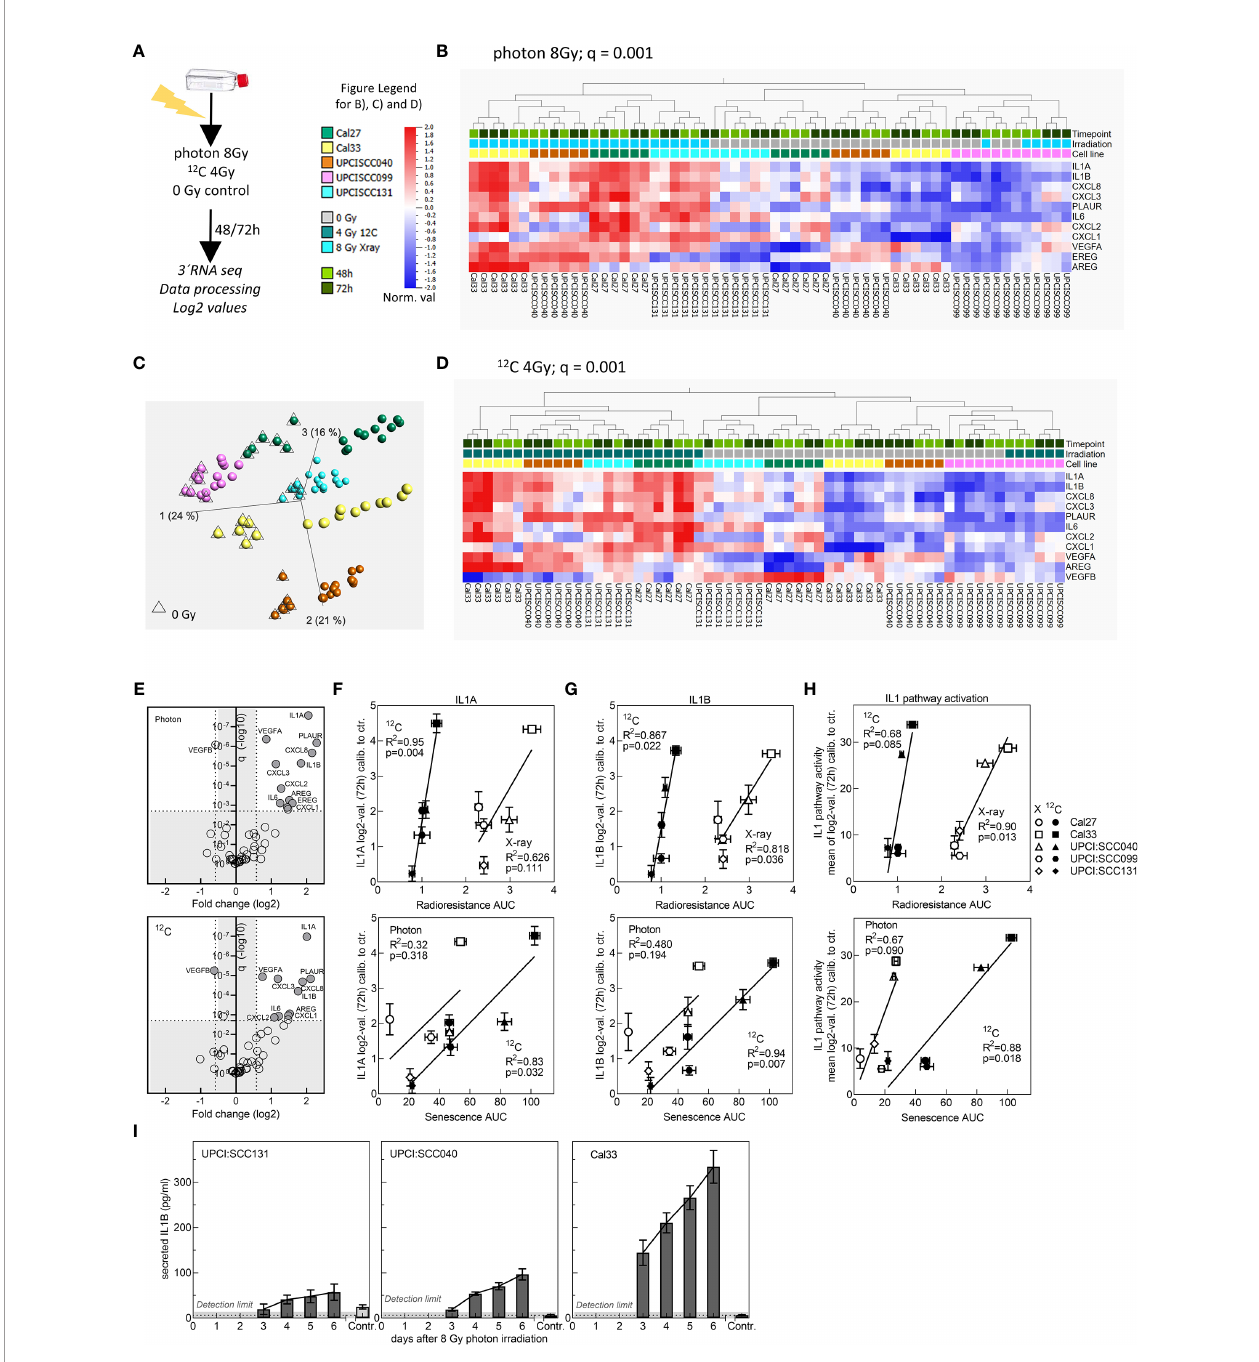
FIGURE 4 | Evaluation of SASP gene expression after irradiation with 8 Gy photons or 4 Gy 12 C-ions. (A) Schematic of experimental procedure. (B) Principal component analysis (PCA) on z-scaled data of the fi ve cell lines for the 49 SASP factors. (C) Hierarchical clustering (fold change >1.5) for 11 genes to separate irradiated from unirradiated samples for photons and (D) 12 C-ions. (E) Plot depicting fold change and q value for signi fi cantly differently expressed genes between unirradiated and irradiated samples for photons and 12 C-ions. (F) IL1A and (G) IL1B values 72 h after irradiation were calibrated to the unirradiated control and correlated with radioresistance AUC or senescence AUC. (H) Correlation of IL1 pathway activity with radioresistance AUC or senescence AUC. Experiments were performed in three biol. replicates. Values are MV+/- SEM. T-test statistics were used for p value calculation. p < 0.05 are considered signi fi cant. R 2 : Pearson coef fi cient. For PCA and hierarchical clustering, log2-transformed, normalized (mean = 0, var = 1) data was used. Benjamini – Hochberg correction was applied, and q < 0.05 was considered signi fi cant. (I) Detection of IL1B protein secretion by ELISA up to 6 days after irradiation with 8 Gy photons in the cell lines UPCI:SCC131, UPCI:SCC040, and